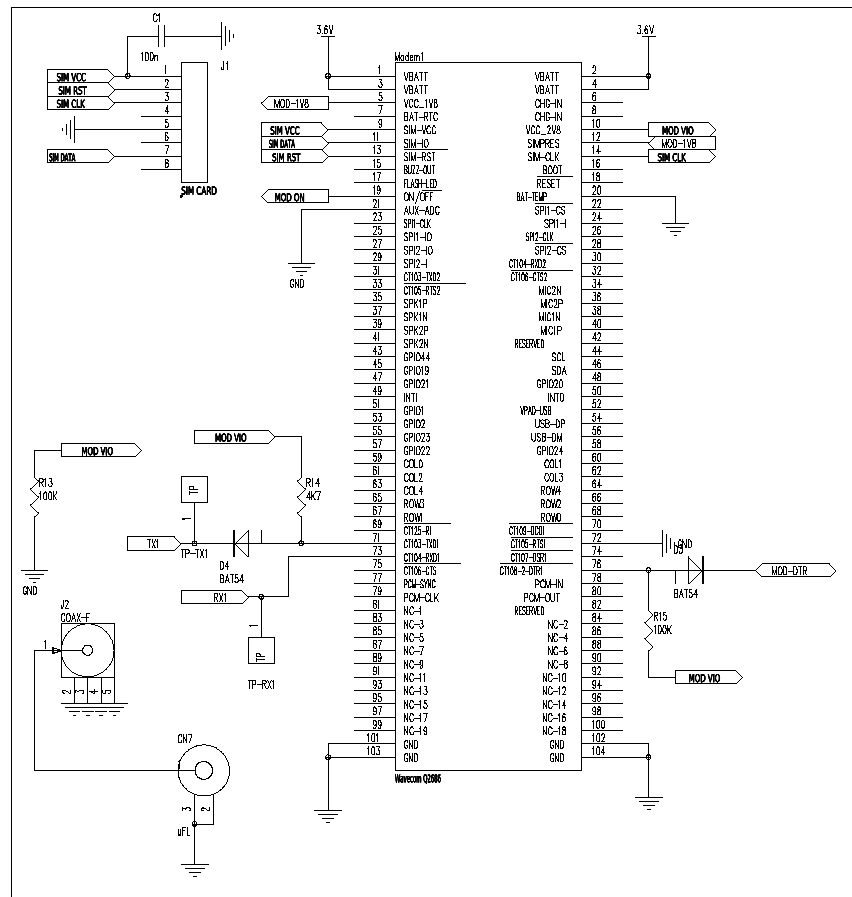
Figure 5. Circuit schematic of the GPRS module. The center portion is the GPRS module used to control the long-distance communication, and the top-left portion is the SIM card